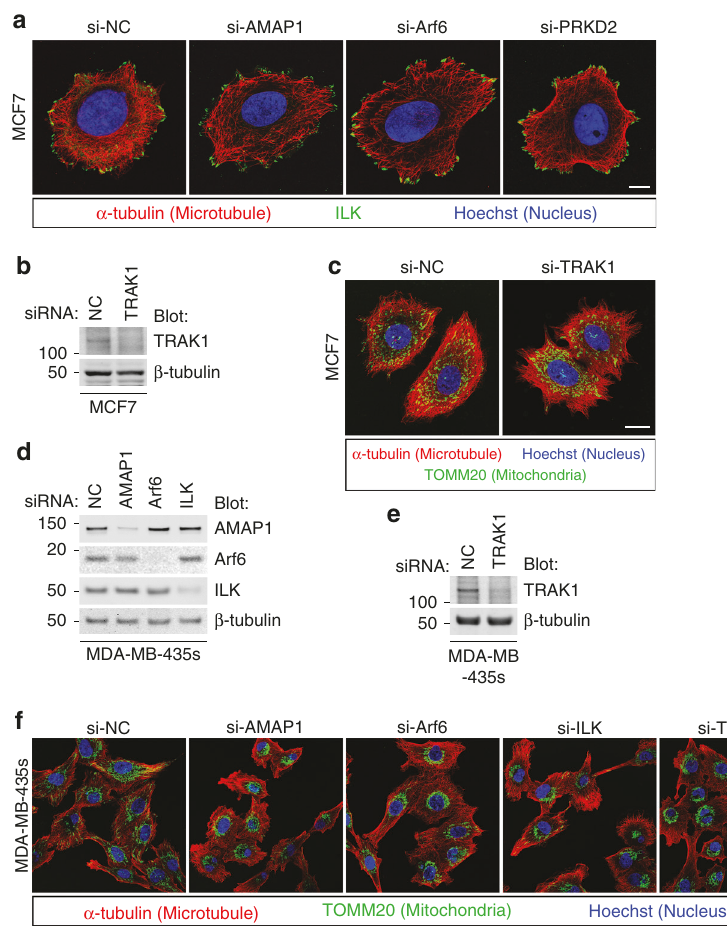
Fig. 7 Utilization of the ILK – RhoT – TRAK axis for regulation of mitochondrial distribution in highly invasive breast cancer cells. a – c MCF7 cells were transfected with siRNAs targeting AMAP1, Arf6, PRKD2, or TRAK1. ILK (green), microtubules (red), and nuclei (blue) were fl uorescently visualized by speci fi c antibodies or dyes. Bar, 10 μ m ( a ). Protein expression of TRAK1 was analyzed by western blotting ( b ). Mitochondria (green), microtubules (red), and nuclei (blue) were fl uorescently visualized by speci fi c antibodies or dyes. Bar, 20 μ m ( c ). d – f MDA-MB-435s cells were transfected with siRNAs targeting AMAP1, Arf6, ILK, or TRAK1. Protein expression of AMAP1, Arf6, and ILK was analyzed by western blotting ( d ). TRAK1 expression was also examined separately ( e ). Mitochondria (green), microtubules (red), and nuclei (blue) were fl uorescently visualized by speci fi c antibodies or dyes. Bar, 20 μ m ( f